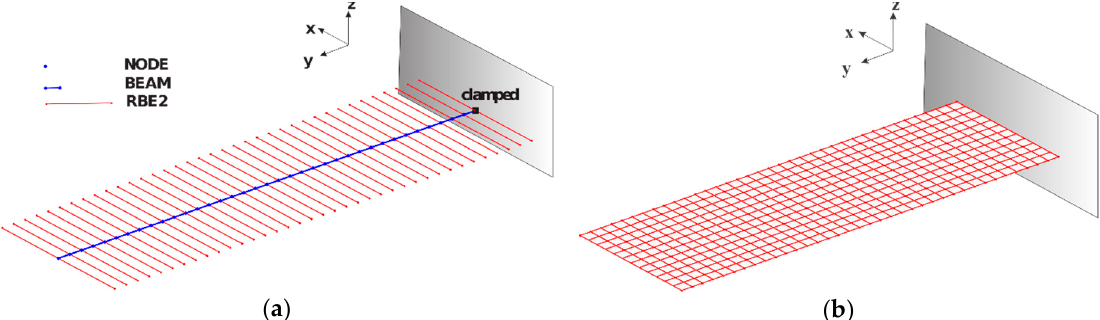
Figure 2. FEM ( a ) and DLM ( b ) numerical arrangement, for the wings with AR = 6. Table 1. FEM and DLM numerical discretisation, for all considered wings. AR FEM: Nodes, Elements DLM: Spanwise,